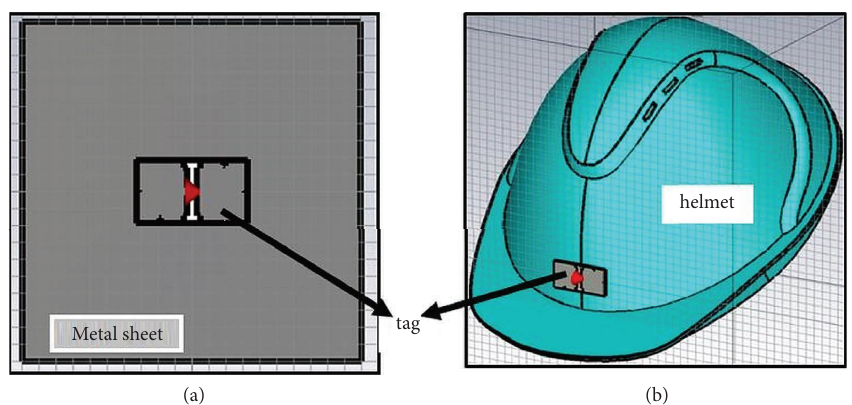
Figure 4: Tag Codesign on (a) metallic surface and (b) ABS plastic-based safety helmet.